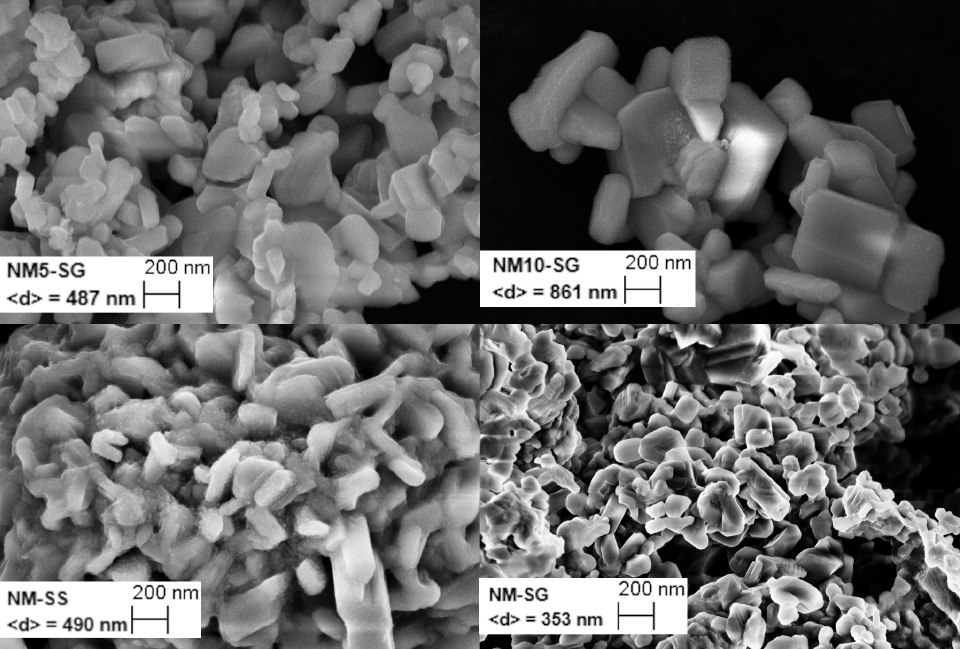
Figure 3. SEM micrographs of the four samples with the average diameter of their respective primary particles (magnifications are identical for all